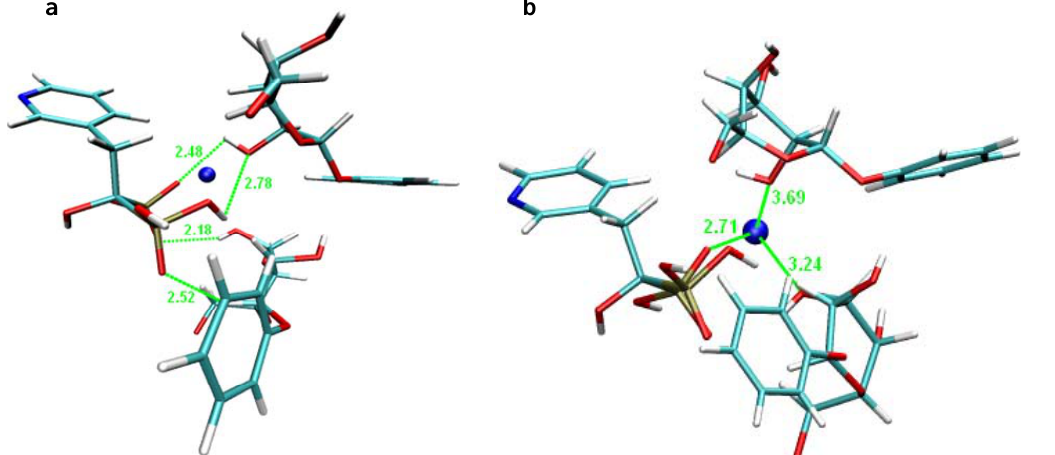
Figure 19. Illustration of supposed interactions of risedronate mono-sodium salt with phenyl- β - D -galactopyranoside: (a) suggested interaction between molecule of risedronate and phenyl- β - D -galactopyranoside; (b) suggested interaction between sodium cation and phenyl- β - D